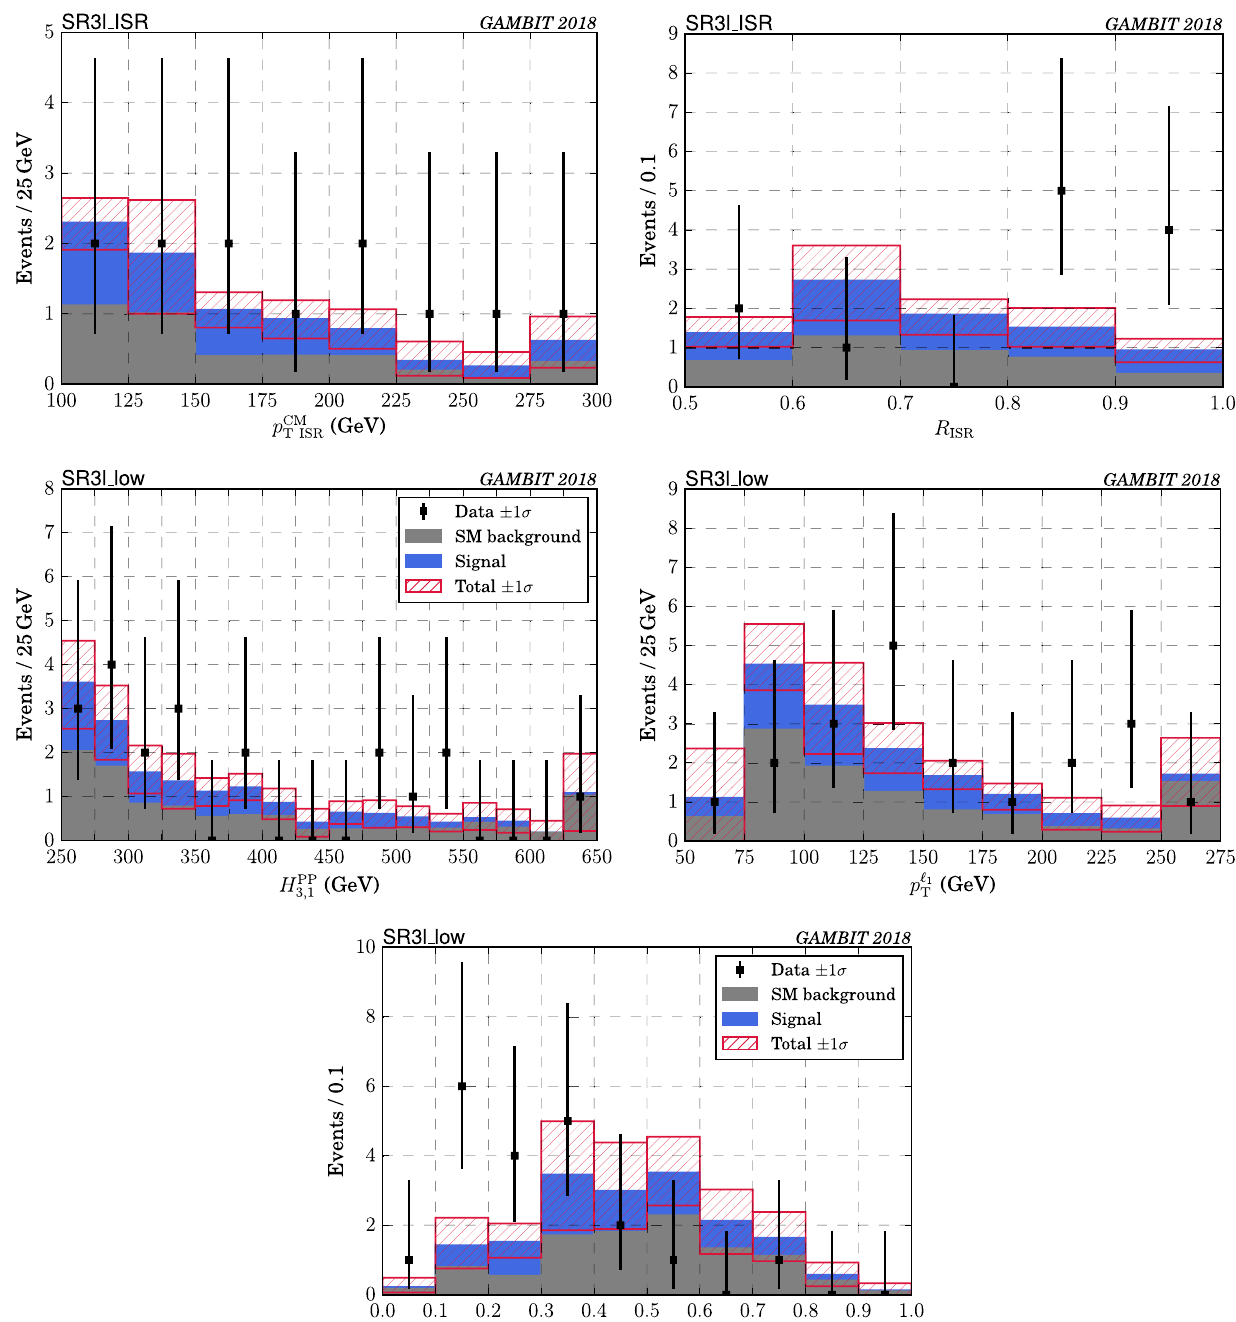
Fig. 14 Distribution of kinematic variables in the 3 lepton signal regions for the ATLAS RJ analysis, after applying all selection require- ments. The grey bars show the total SM background (taken from Ref. [117]) and the stacked blue bars show the signal for our best-fit point.